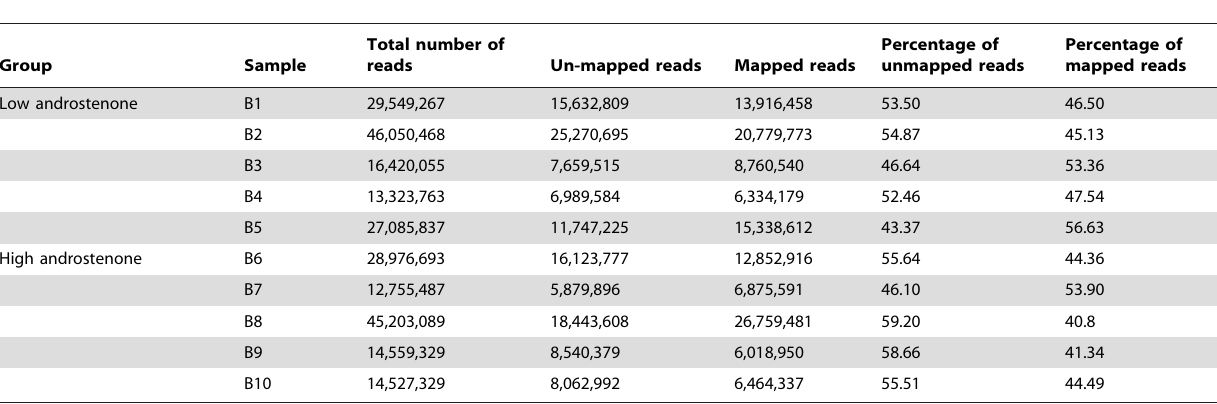
Table 2. Summary of sequence read alignments to reference genome in liver samples.